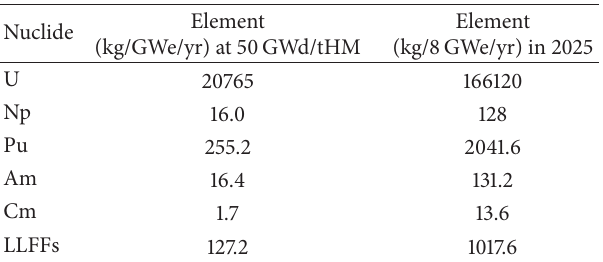
Figure4:FuelcyclewiththeADSutilizingthoriumandreprocessed